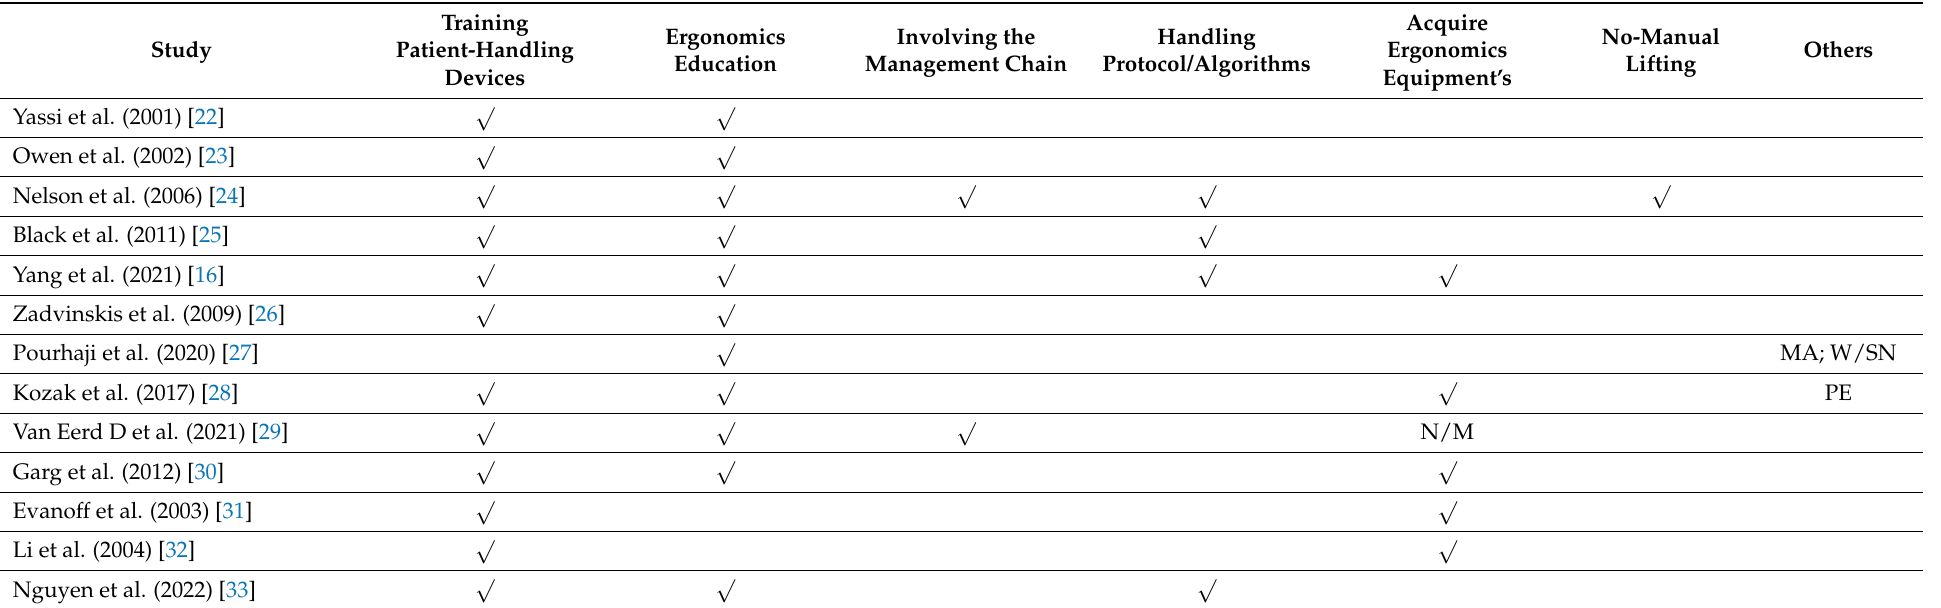
Table 6. Type of